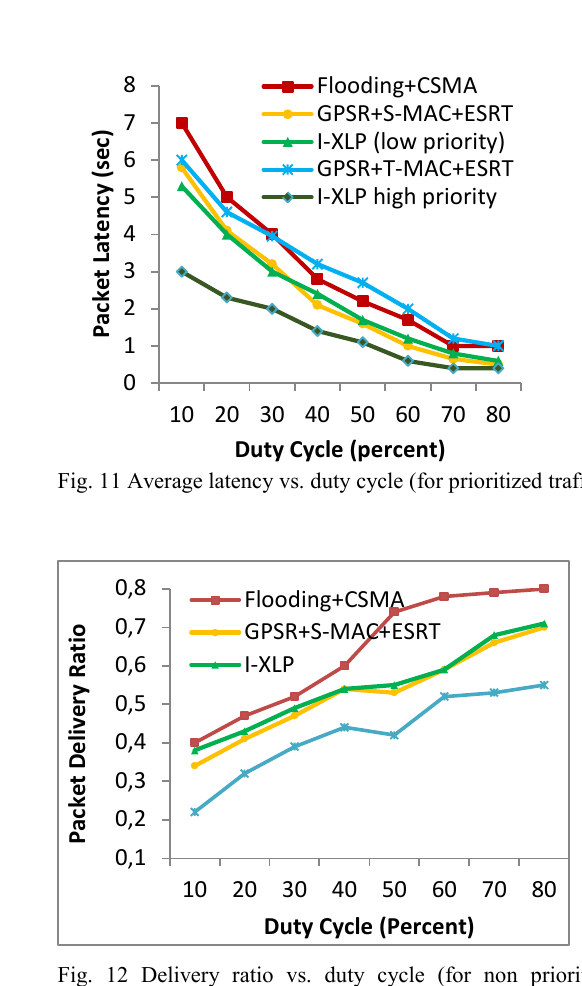
Fig. 9 Average energy consumption per bit vs. duty cycle (for prioritized traffic).